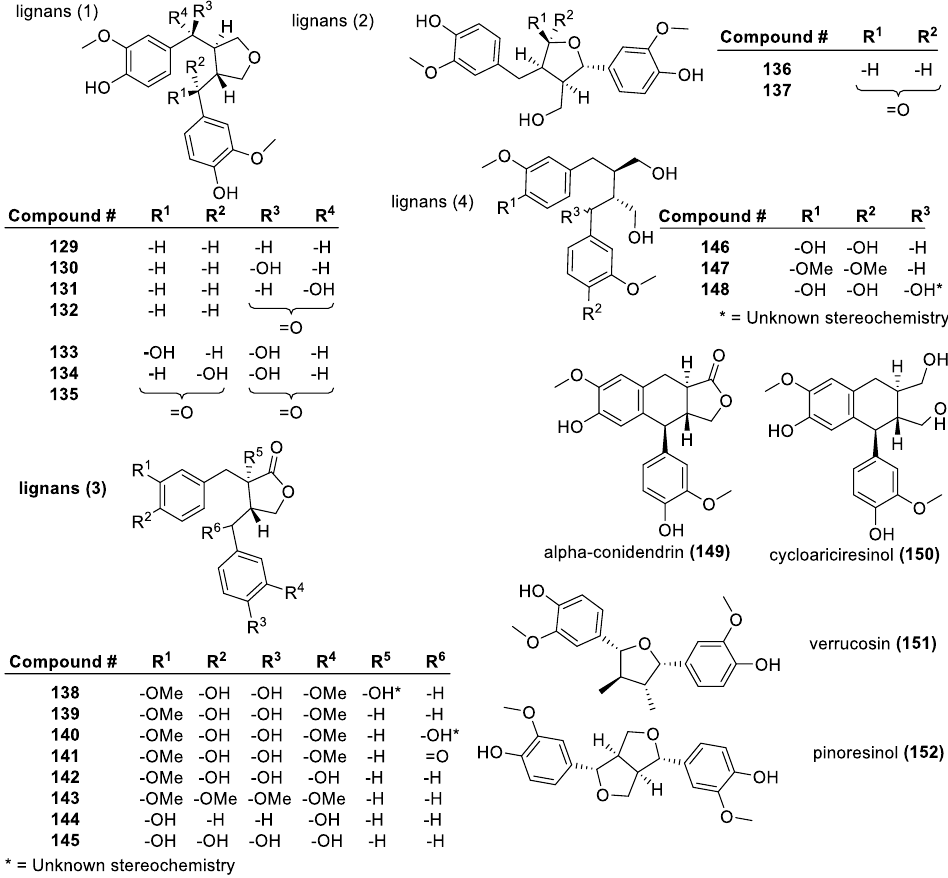
Figure 9. The structure of selected lignan-based antioxidants. Flavonoids